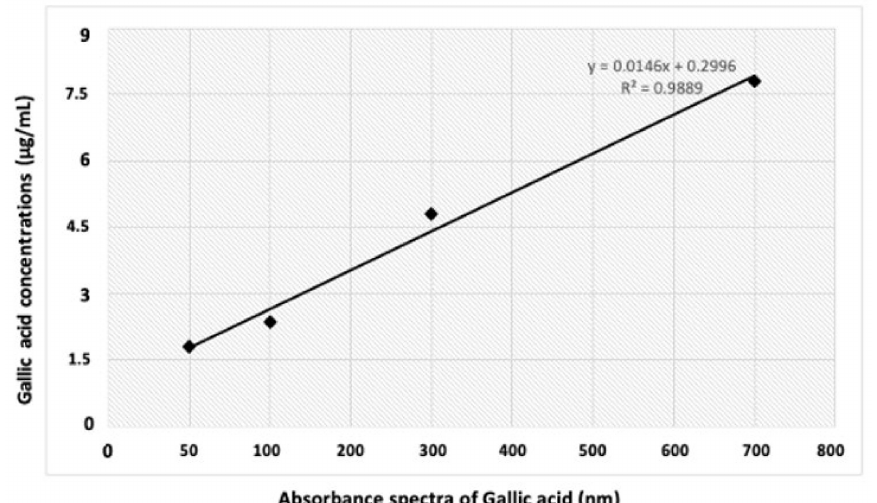
Figure 2. Standard calibration curve for gallic acid, where “y” is the absorbance spectra of each concentration, “x” represents the concentration of gallic acid (Sigma; 1.0 − 10 µ g/mL), and “ R 2 ” represents the correlation coefficient. A similar plot was also calibrated for the different concentrations of quercetin to compare the treated samples for the investigation of flavonoids contents where the correlation coefficient ( R 2 ) values fall within in the range of